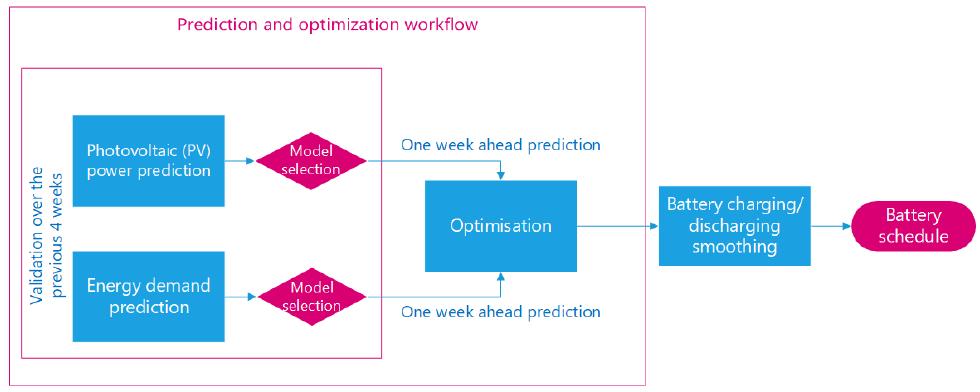
Figure 1. Illustration of the workflow of the proposed